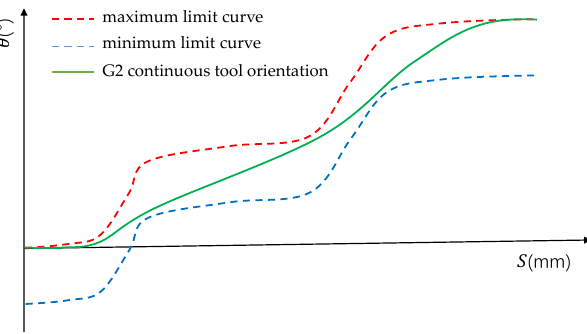
Figure 11. Smoothed tool orientation angle variation curve.